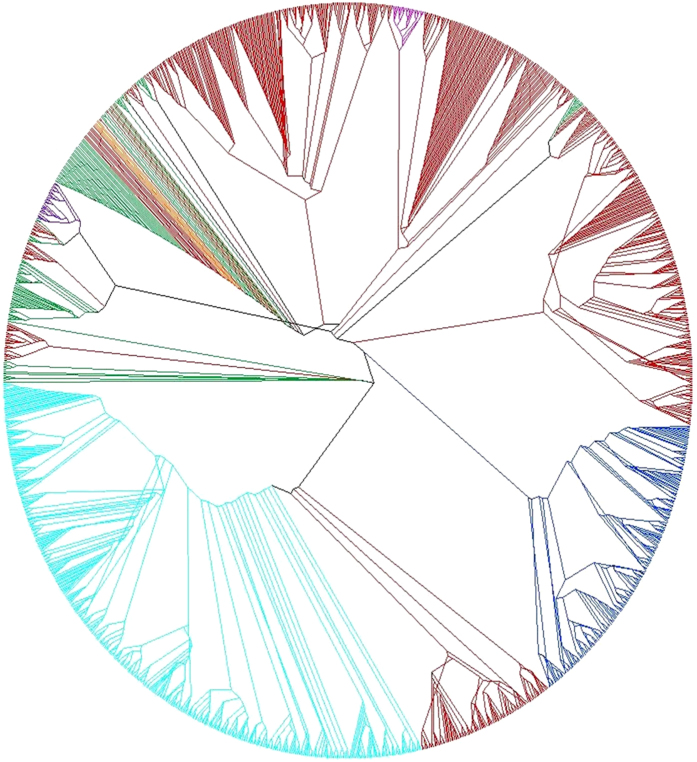
Global phylogeny of 1377 M.
tuberculosis isolates based on IS6110 insertion sites.Different colors represent isolates from different lineages. L1: green; L2: cyan; L3: blue; L4: red; L5: purple; L6: violet; L7: orange.